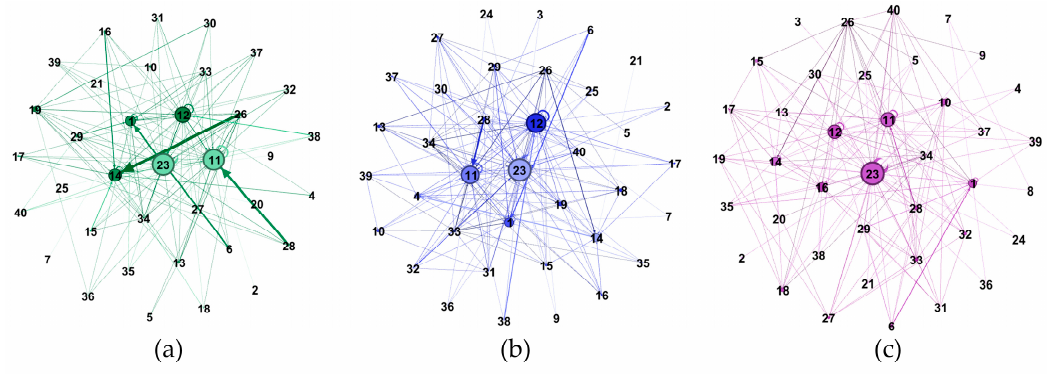
Figure 6. Cumulative probability distribution of the weighted edges. The abscissa is the number of edges in the network, and the ordinate is the cumulative probability of the weighted edges sorted in descending order.